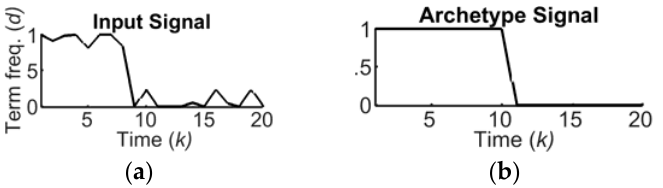
Figure 5. ( a ) Example of input signal for an SRF; ( b ) Corresponding archetype signal.